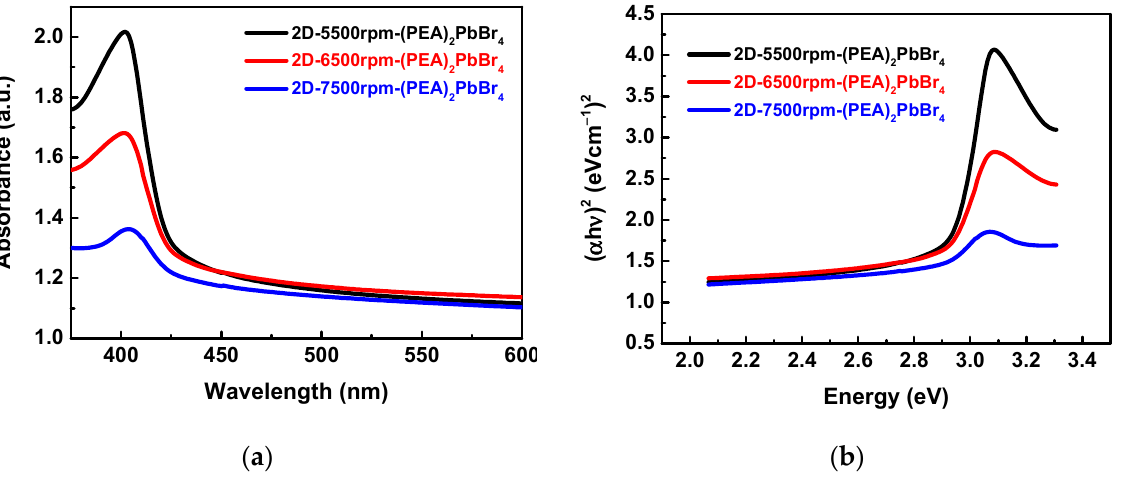
Figure 6. ( a ) Optical absorption spectra and ( b ) ( α h ν ) 2 vs. energy plot of 2D-(PEA) 2 PbBr 4 with different spin speeds.